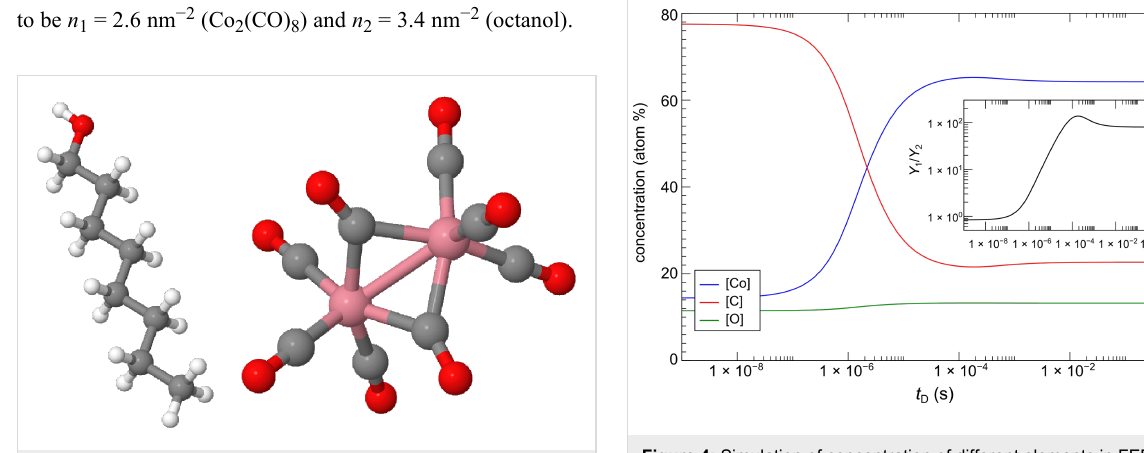
Figure 3: Molecular models of octanol (left) and Co 2 (CO) 8 (right). Rendered using Jmol.